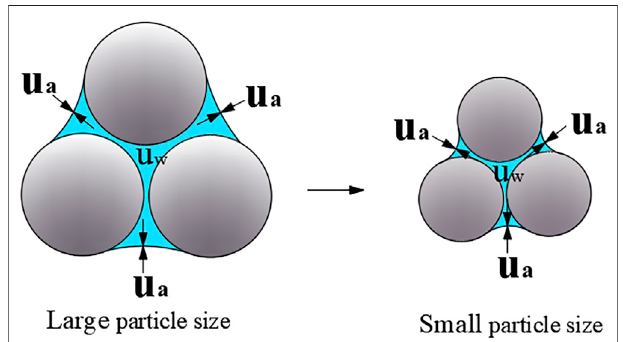
FIGURE 6 | Meniscus forces between tailings particles at different average particle